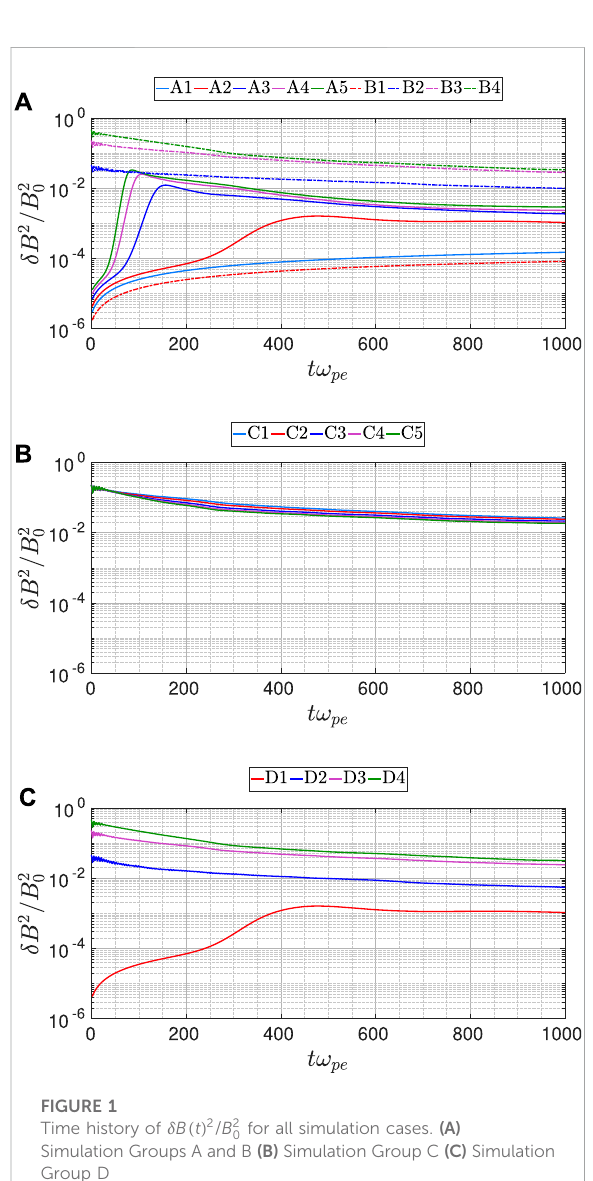
FIGURE 1 Time history of δ B ( t ) 2 / B 2 0 for all simulation cases.